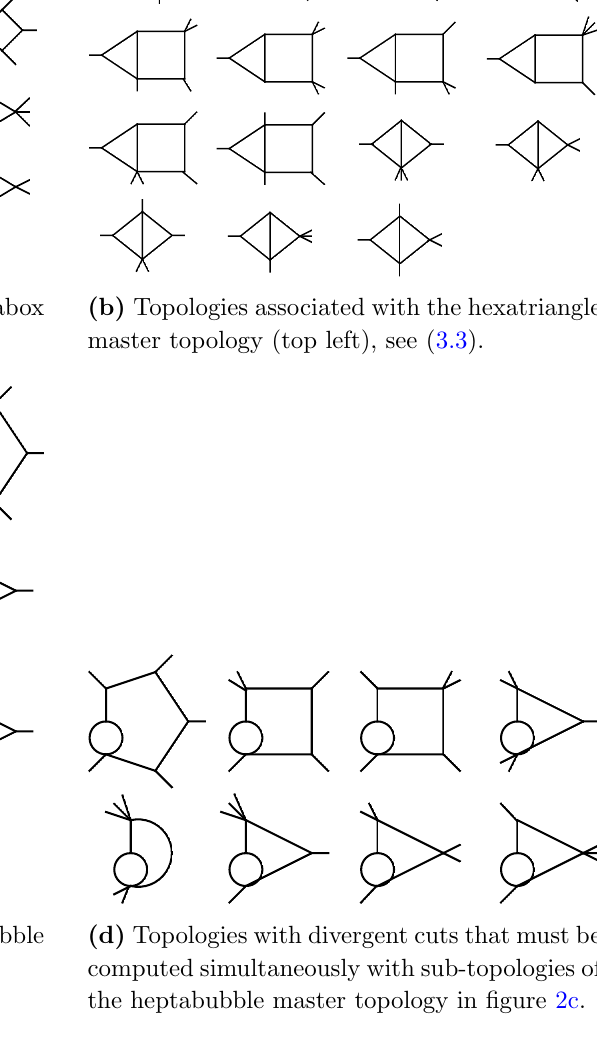
Figure 2. All distinct two-loop (cid:12)ve-point